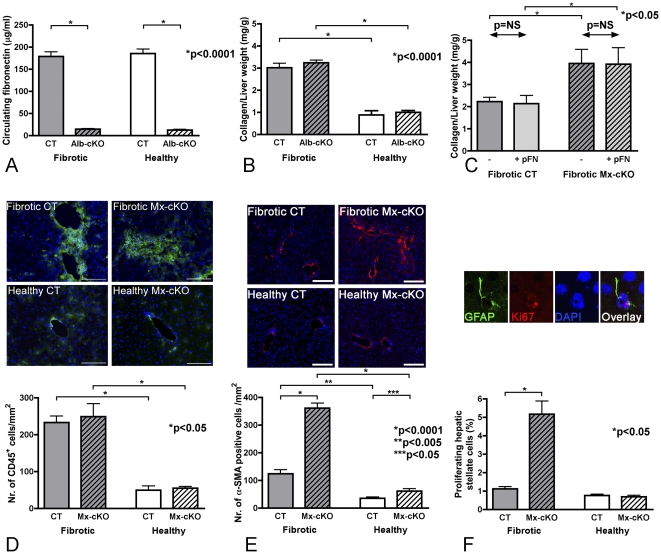
Determining the cell type associated with increased collagen production in Mx-cKO mice.Experiments shown in panels A and B were performed in Alb-cKO mice lacking fibronectin in the hepatocytes only in order to determine whether the absence of fibronectin in hepatocytes affects the degree of fibrosis. Experiments shown in panels C–F were performed in Mx-cKO mice lacking fibronectin in both hepatocytes and stellate cells to determine which cell type is involved in increased matrix production (shown in figures 2D and 2E). Experiments in Alb-cKO mice: (A) ELISA for circulating fibronectin shows that deletion of fibronectin in hepatocytes only by using the albumin promoter to drive cre expression (Alb-cKO) results in decreased circulating fibronectin levels in Alb-cKO mice. Fibrosis does not result in an increase in the amount of circulating fibronectin in CT or Alb-cKO compared to healthy mice of the same genotype. The same relationship was true for Mx-cKO mice (shown in Figure 2A). N = 7–8 mice/group. (B) Collagen quantification based on hydroxyproline measurements shows that collagen increases in fibrotic animals but unlike Mx-cKO mice (Figure 2E) there is no difference between fibrotic Alb-cKO and fibrotic CT animals in the absence of fibronectin in hepatocytes only. Triplicate measurements/mouse were performed. N = 11–13 mice/fibrotic group and 3 mice/healthy group. Experiments performed in Mx-cKO mice lacking fibronectin production in both the hepatocytes and the stellate cells: (C) Administration of plasma fibronectin (pFN) at the same time as fibrosis induction does not affect the degree of fibrosis in CT mice or Mx-cKO mice. Mice received daily injections of fibronectin (1 mg/mouse) beginning one day before start of fibrosis induction with DMN. Mice were euthanized after 4 weeks of experimental fibrosis and collagen content in the liver was quantified. N = 4 mice/group. (D) The number of inflammatory cells is similar between fibrotic mice lacking fibronectin in hepatocytes and stellate cells (Mx-cKO) and fibrotic controls. Upper panel: Representative pictures showing almost equivalent numbers of inflammatory cells (stained with CD45+) in the two fibrotic groups and in the two healthy groups. Bars represent 100
µm. Lower panel: Quantification of the number of CD45+ cells. N = 3 mice/group. (E) Increased number of α-SMA stained cells and hence activated stellate cells in fibrotic Mx-cKO mice compared to fibrotic controls. Upper panel: Representative pictures showing increased α-SMA stained cells in Mx-cKO mice compared to controls in both the healthy and the fibrotic groups. Bars represent 100
µm. Lower panel: There is a significant increase in the number of α-SMA positive cells in the absence of fibronectin in stellate cells (in Mx-cKO mice). N = 4 mice/group. (F) Proliferation of stellate cells in Mx-cKO mice is increased. Co-staining of liver sections with ki-67 (to identify proliferating cells) in red and GFAP (to identify stellate cells) in green was performed. Upper panel: A single cell is enlarged to show how the cells were analyzed. Only cells stained positive for GFAP and showing the characteristic pink color in the overlay of ki-67 and DAPI were counted as proliferating stellate cells. Lower panel: More proliferation was found in fibrotic Mx-cKO mice. N = 3–4 mice/group.